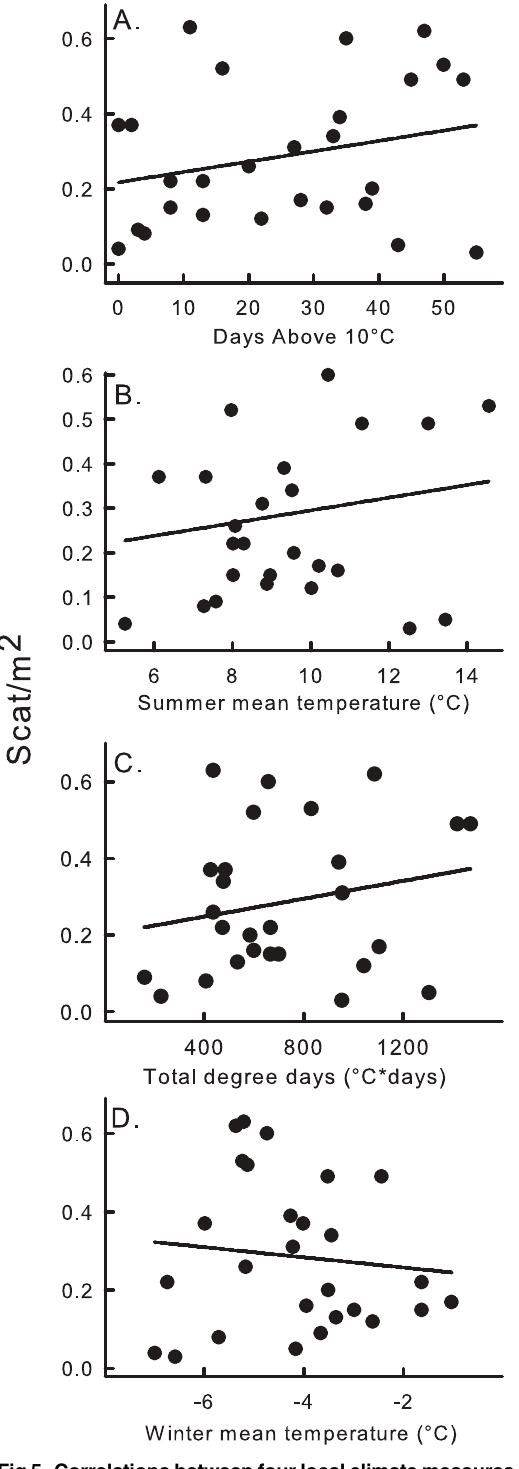
Fig 5. Correlations between four local climate measures and elevation. Climate variables included from top to bottom: number of days above 10°C, adj. r 2 = 0.34; mean summer temperature, adj. r 2 = 0.28; total degree days (°C * days), adj. r 2 = 0.33; and mean winter temperature, adj. r 2 = 0.09. All data were obtained via ibutton sensors deployed at 27 sites in the Wind River Range, Wyoming, USA for one year starting in August 2010.